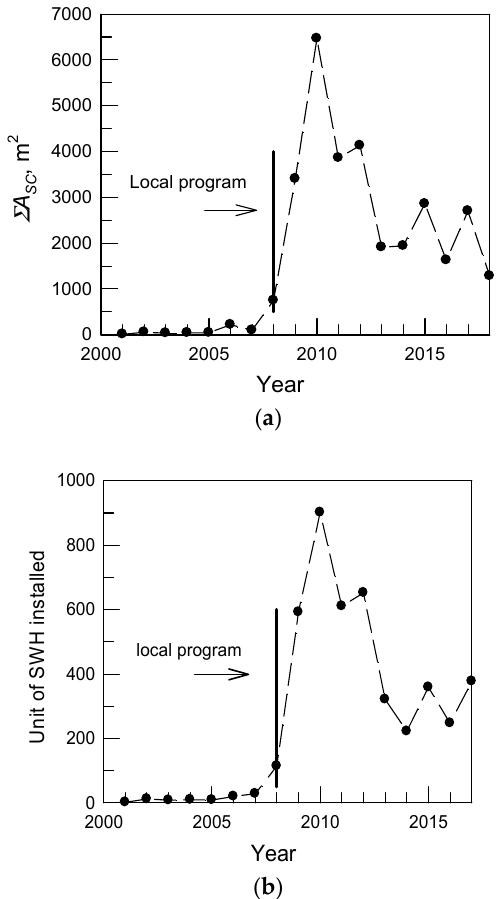
Figure 3. SWHs installed for Kinmen (2001–2018). ( a ) Annual area of solar collectors installed; ( b ) Unit of SWHs